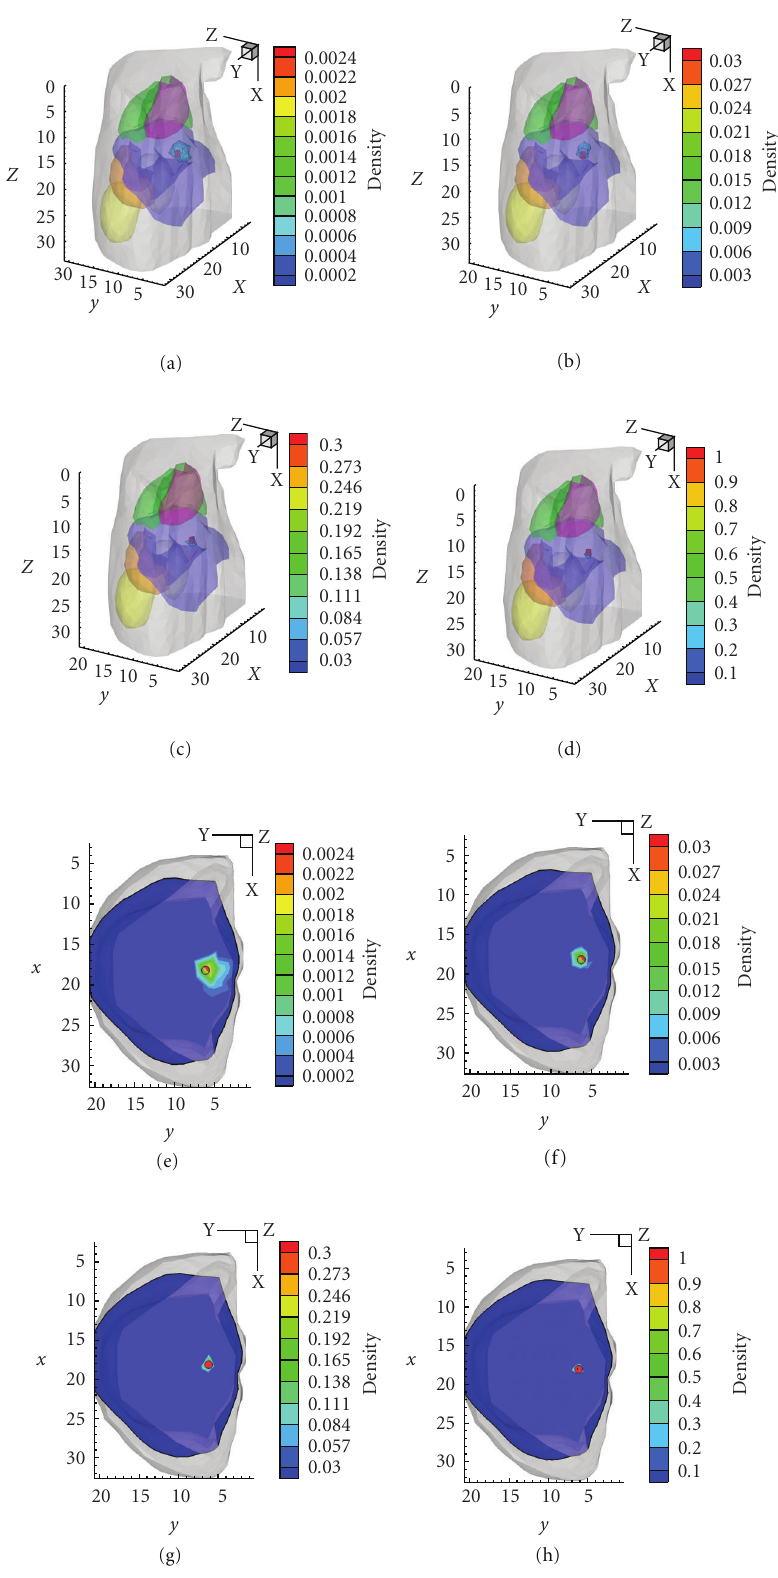
Figure 7: Reconstruction results of 3D digital mouse model on di ff erent mesh level. (a)–(d) are the 3D view of the results by the proposed method from the first level to the fourth level, respectively. (e)–(h) are the corresponding XY view of these results, where the small black circles indicate the real